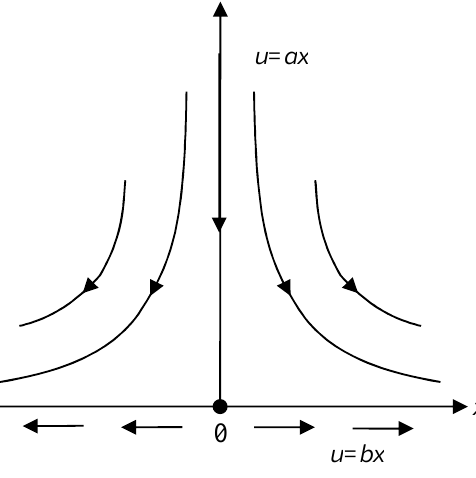
Fig. 1. Physical model and coordinate